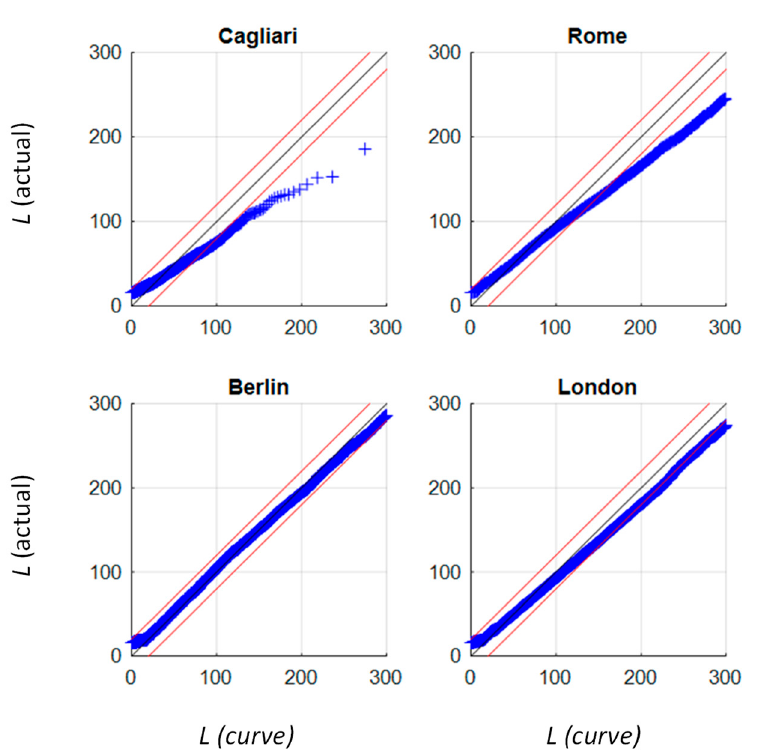
Figure 13. Q-Q plots for L ; actual data on the Y -axis, best-fit curves on the X -axis; the black line is the bisector, the two red straight lines highlighting a tolerance interval.